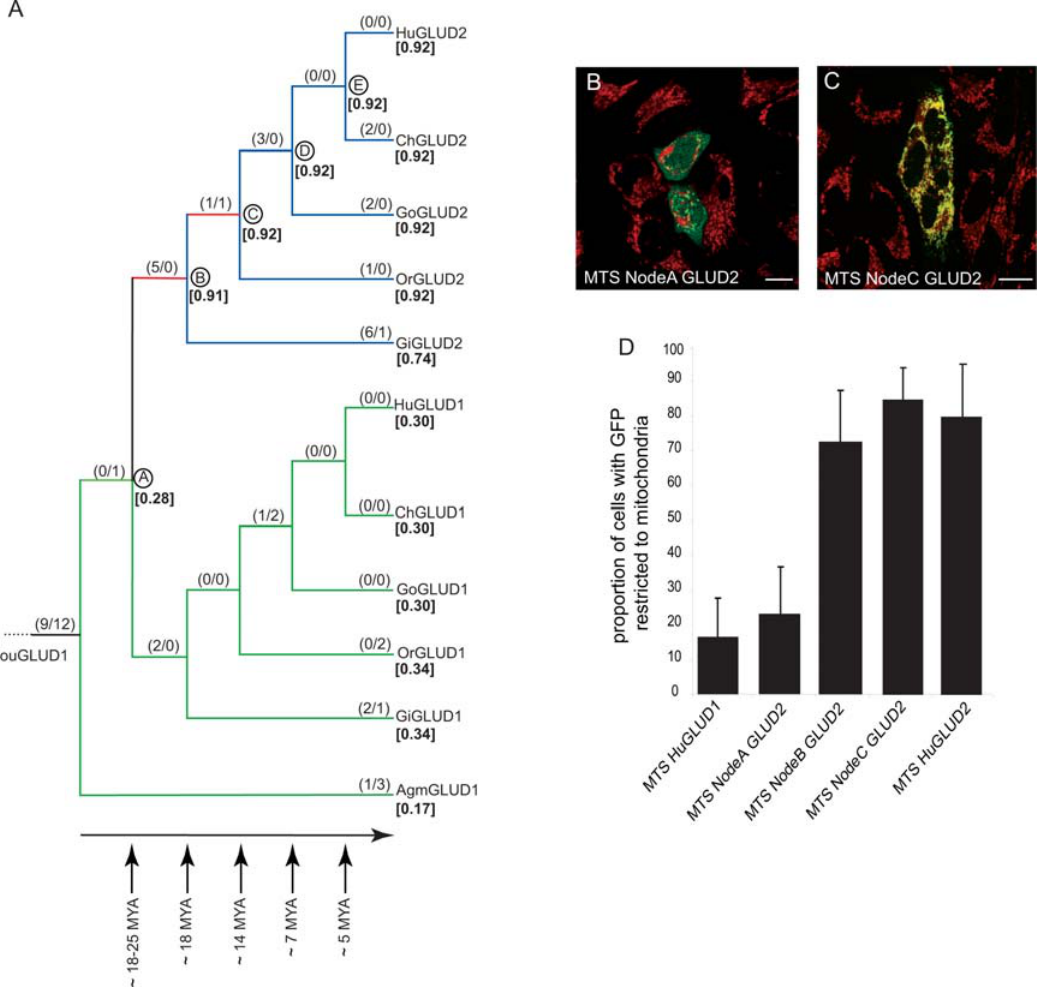
Figure 1. Coding Sequence Evolution of the GLUD1/GLUD2 MTSs and Subcellular Localization of MTS-GFP Fusion Proteins. (A) Phylogenetic tree based on GLUD1/GLUD2 MTS coding sequences (GLUD1 from mouse is used as an outgroup). Approximate divergence times in millions of years (MYA) are shown (estimates are based on ref. [36]). Maximum likelihood d N / d S values and the estimated number of nonsynonymous over synonymous substitutions (in parentheses) for each branch are indicated (estimated numbers of substitutions are rounded to the nearest integer). The two internal branches for which positive selection was previously inferred for the mature protein [7] as well as here for the full-length protein (including the MTS) are highlighted in red. Overall d N / d S rates after the duplication event for GLUD2 (blue and red branches; d N / d S , 2) and GLUD1 (green branches; d N / d S , 0.2) were inferred and found to be significantly different (see main text and Materials and Methods for details). Estimated probabilities of mitochondrial targeting (see Materials and Methods) are indicated within square brackets (in bold). We note that the ancestral node B and C sequences could not be unambiguously established at positions 24 and 25 due to the deletion on the gibbon lineage at these sites (the substitutions A24N and D25H were assigned to branch A–B by the reconstruction method—as depicted—although they may with equal probability have occurred on branch B–C; see Materials and Methods). Abbreviations: human CDC14Bretro, HuRetro; chimpanzee CDC14Bretro, ChRetro; gorilla CDC14Bretro, GoRetro; orang-utan CDC14Bretro, OrRetro; gibbon CDC14Bretro, GiRetro; human CDC14Bpar, HuPar. (B) LN229 cells transfected with the GLUD2 MTS (fused to GFP) from node A. (C) LN229 cells transfected with the GLUD2 MTS-GFP from node C. Mitochondria were stained (red) with MitoTracker. The images are representative of the predominant subcellular phenotypes observed for the different constructs.